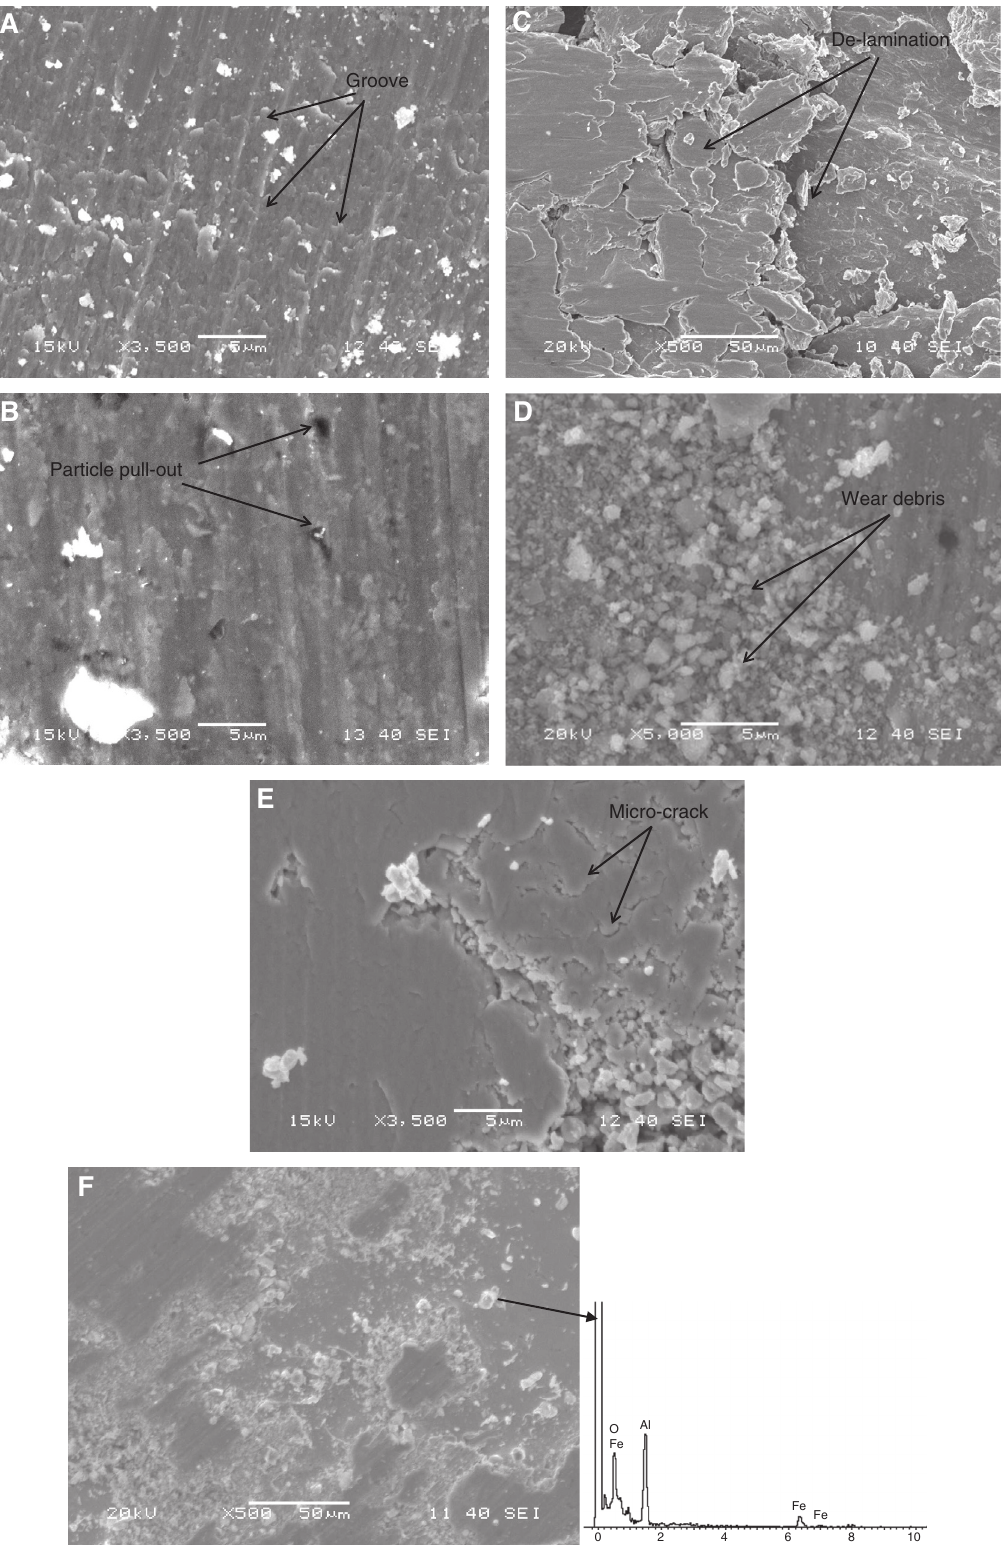
O nanocomposite, (B) Cu-5 vol.% Al 2 3 O nanocomposite, (F) Cu-20 vol.% Al 2 3